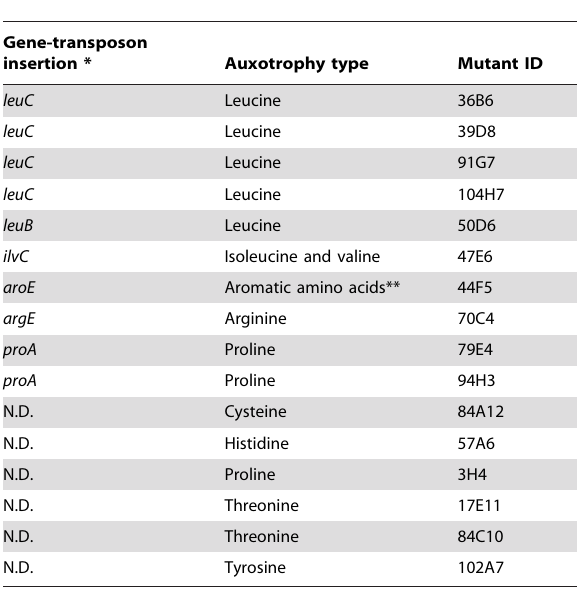
Table 1. Auxotrophic transposon mutants with increased antibiotic tolerance in